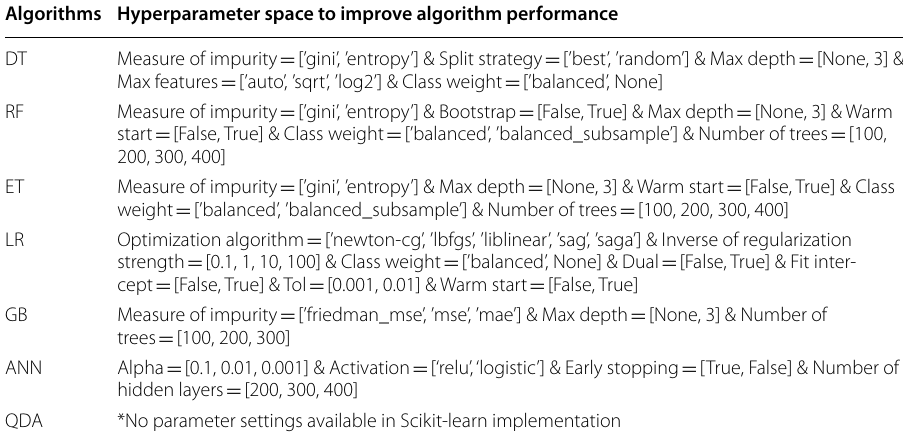
Decision Tree (DT), Random Forest (RF), Extra Trees (ET), Logistic Regression (LR), Gradient Boosting (GB), Artificial Neural Network (ANN), and Quadratic Discriminant Analysis (QDA)